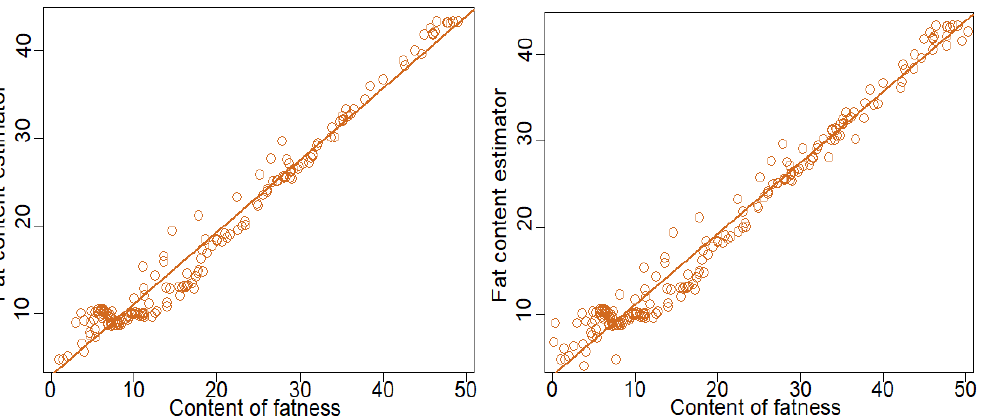
Figure 7. On the left plot: the content of fatness and its estimation, Gaussian case. On the right plot: the content of fatness and its estimation, logistic